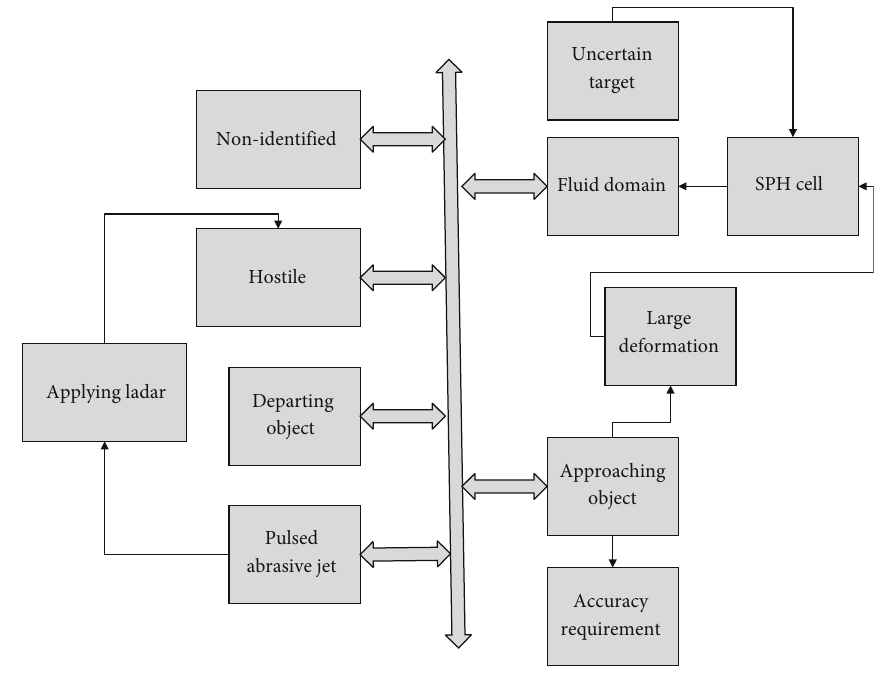
Figure 1: Traditional target detection process.